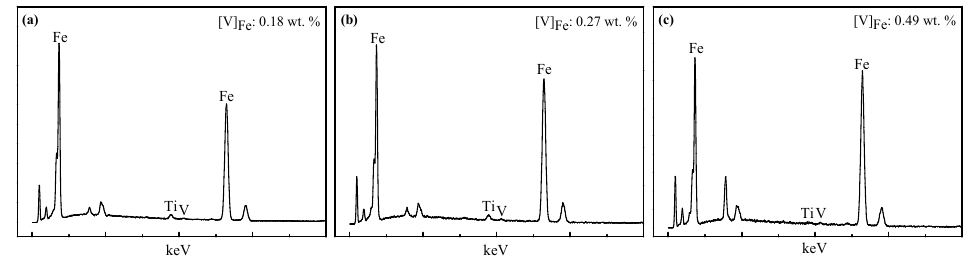
Figure 6. EDS analysis of different light grey areas: ( a ) area A; ( b ) area B; ( c ) area E; and ( d ) area F.